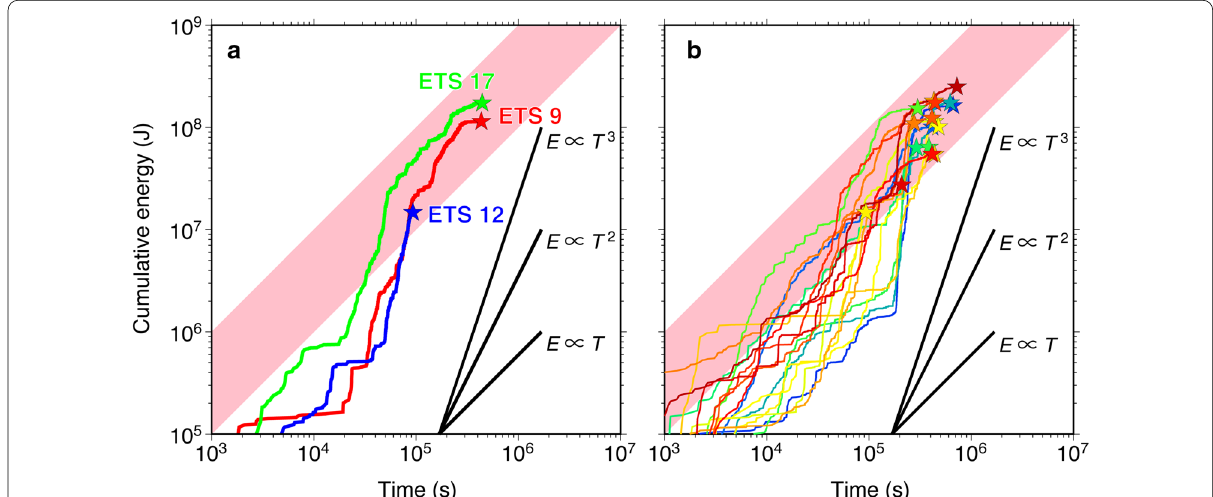
Fig. 9 Logarithmic plot of the evolution of cumulative seismic energy release ( a ) for the three ETS events shown in Fig. 8b and b for all ETS events. The pink zone represents a scaling relation of M O lines indicate scaling relations of E